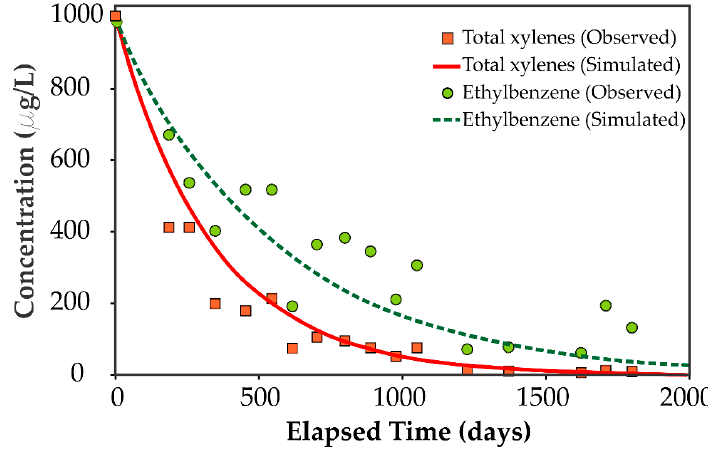
Figure 9. Comparison of observed and simulated ethylbenzene and total xylene concentrations in the aqueous phase.